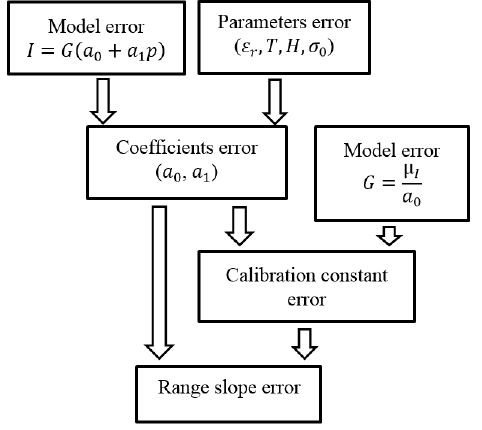
Figure 2. Error sources on range slope estimation. Two kinds of model errors affect surface reconstruction and errors on the coefficients cause error on the calibration constant.